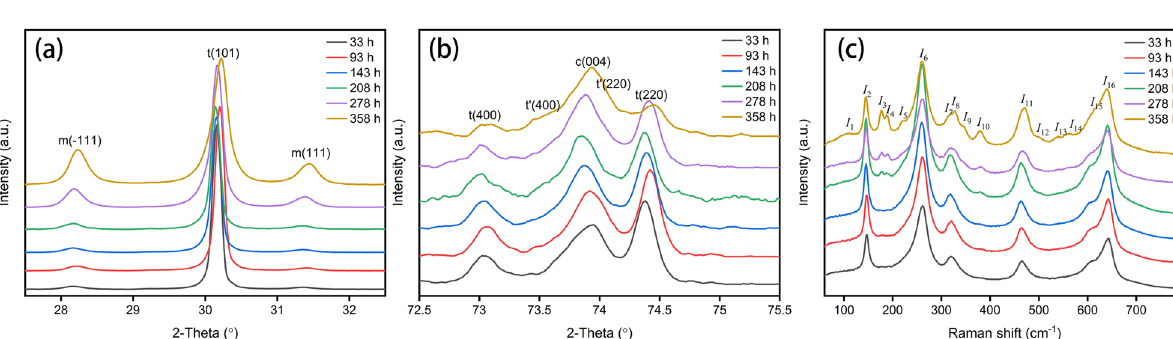
Figure 3. XRD patterns ( a ) 2θ = 27.5°–32.5°, ( b ) 2θ = 72.5°–75.5°, and ( c ) Raman spectra of 8.5YSZ ceramics after heat treatment for different times.